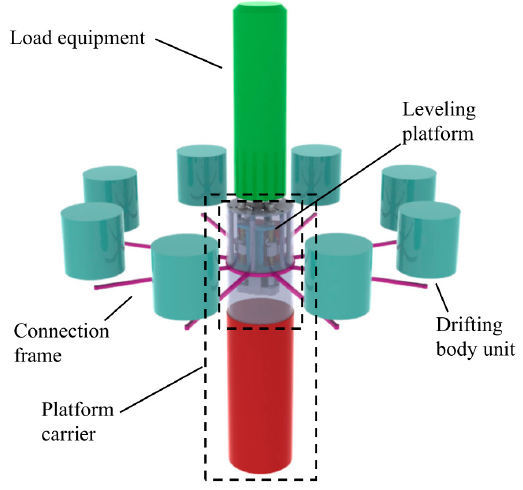
Figure 1. Structure diagram of a surface unmanned drifting platform.